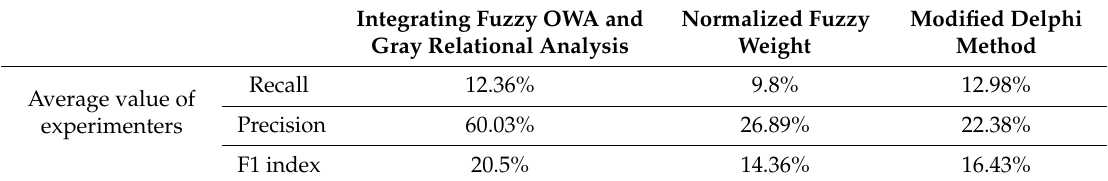
Table 5. Condition setting of evaluating the efficiency measurement